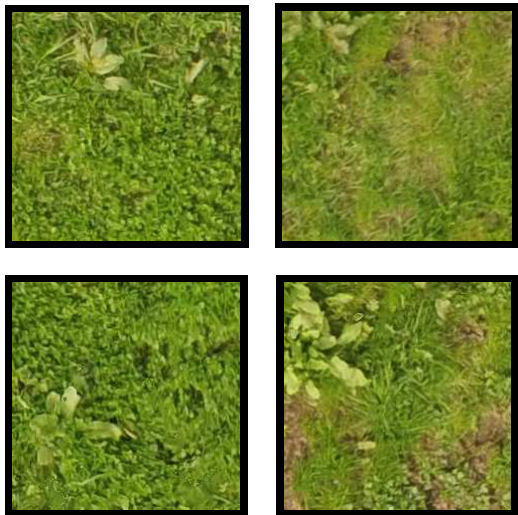
Figure 10. Decentralized and partly cut off Rumex obtained from orthomosaic generated from the UAV flight: a) plant displaced from the centre (top-left), b) plant partially cut-off (top-right), c) plant displaced from the centre (bottom-left), and plant partially cut-off (bottom-right).